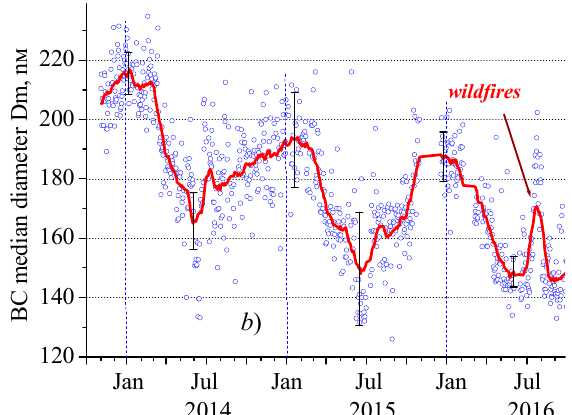
Figure 3. Monthly average size distributions of the absorbing matter in 2016 ( a ) and temporal dynamics of the absorbing matter median diameter D m in 2014–2016 ( b ) (solid curves are monthly average values at 30-day smoothing; dots show the daily average values).